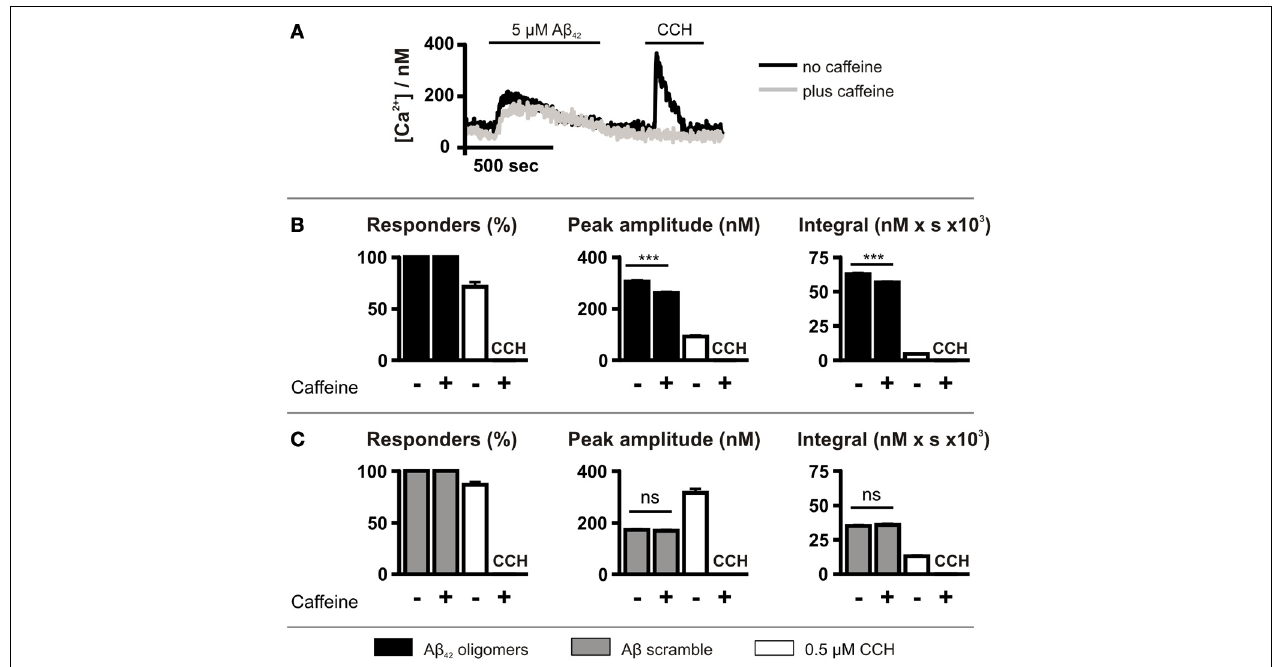
FIGURE 4 | A β 42 oligomer-induced Ca 2 + release is sensitive to caffeine. (A) Imaging protocol employed to investigate the involvement of InsP 3 Rs in A β 42 oligomer-mediated Ca 2 + release from the ER. InsP 3 Rs were inhibited by co-administration of caffeine. (B,C) Bar charts illustrating the magnitude of Ca 2 + responses elicited by SH-SY5Y cells following the application of 5 μ M